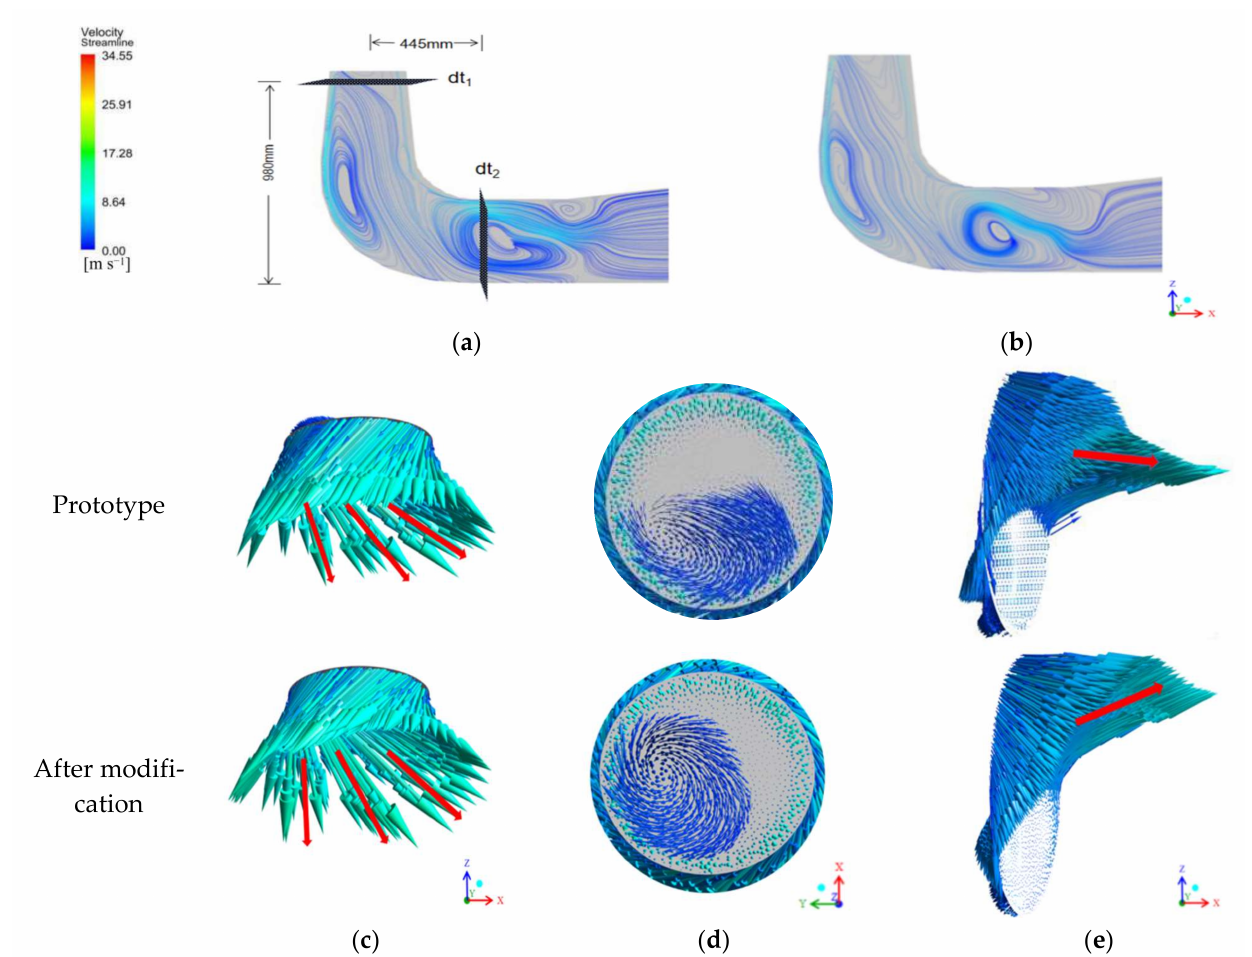
Figure 10. Overall velocity flow line of the draft tube before and after the modification and velocity vector diagram of the characteristic section at t = T (0.46404 s). ( a ) Prototype flow chart. ( b ) Modified flow chart. ( c ) d t 1 Cross-sectional streamline vector drawing. ( d ) d t 1 Cross-sectional flow vector top view. ( e ) d t 2 Cross-sectional streamline vector